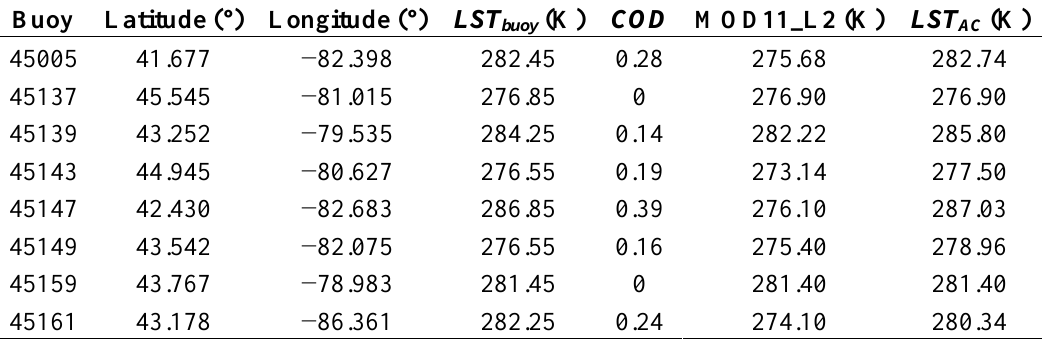
Table 3. Buoy locations and buoy-measured lake water temperature ( LST buoy ) for MODIS/Terra observations on 6 May 2013; cirrus optical depth ( COD ) at 0.55 μm, MODIS/Terra LST products-MOD11_L2, and MOD11_L2 after correction ( LST AC ) for the pixels where the buoys are located.